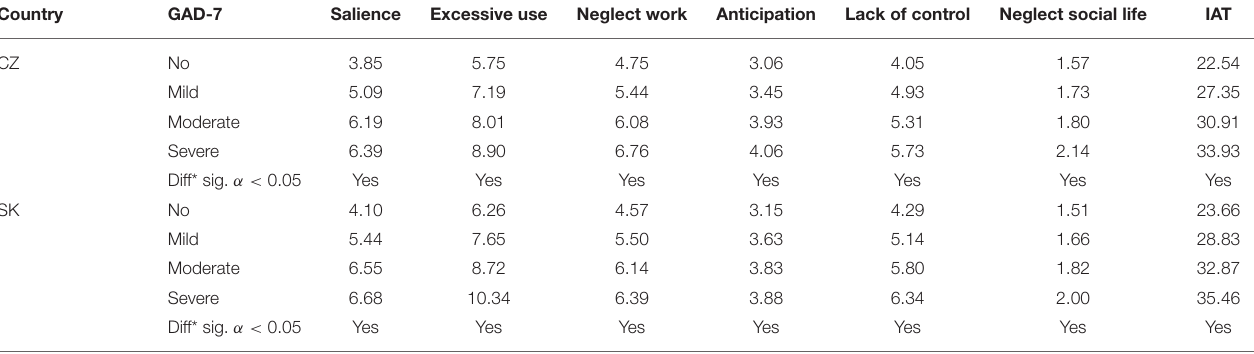
TABLE 11 | Mean values of the IAT and its subscales in the classification by severity of anxiety symptoms. Country GAD-7 Salience Excessive use Neglect work Anticipation Lack of control Neglect social life IAT CZ